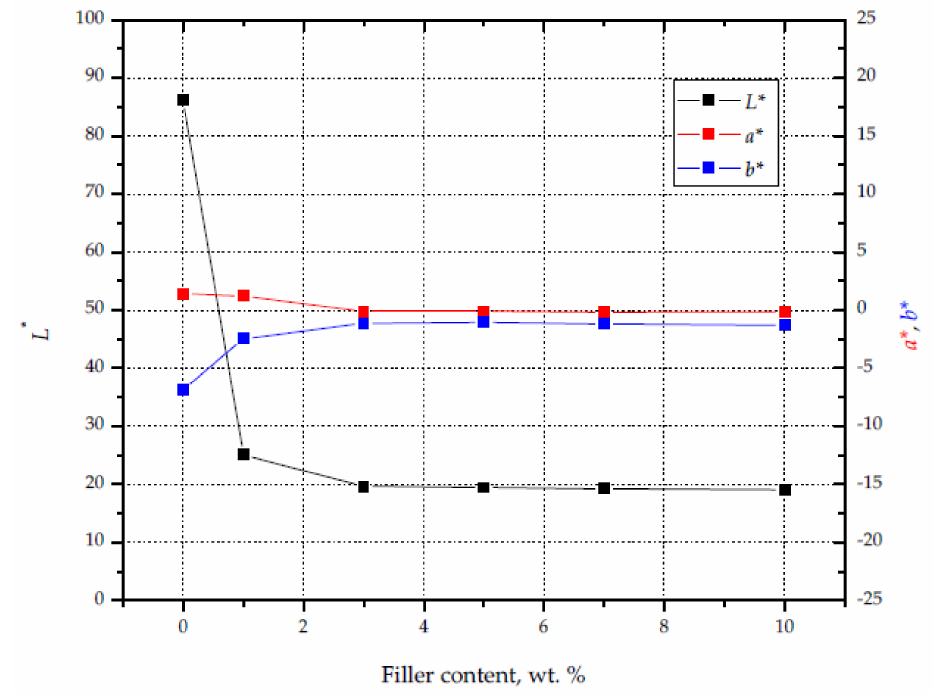
Figure 9. Influence of silica content on L* , a* , and b* values.